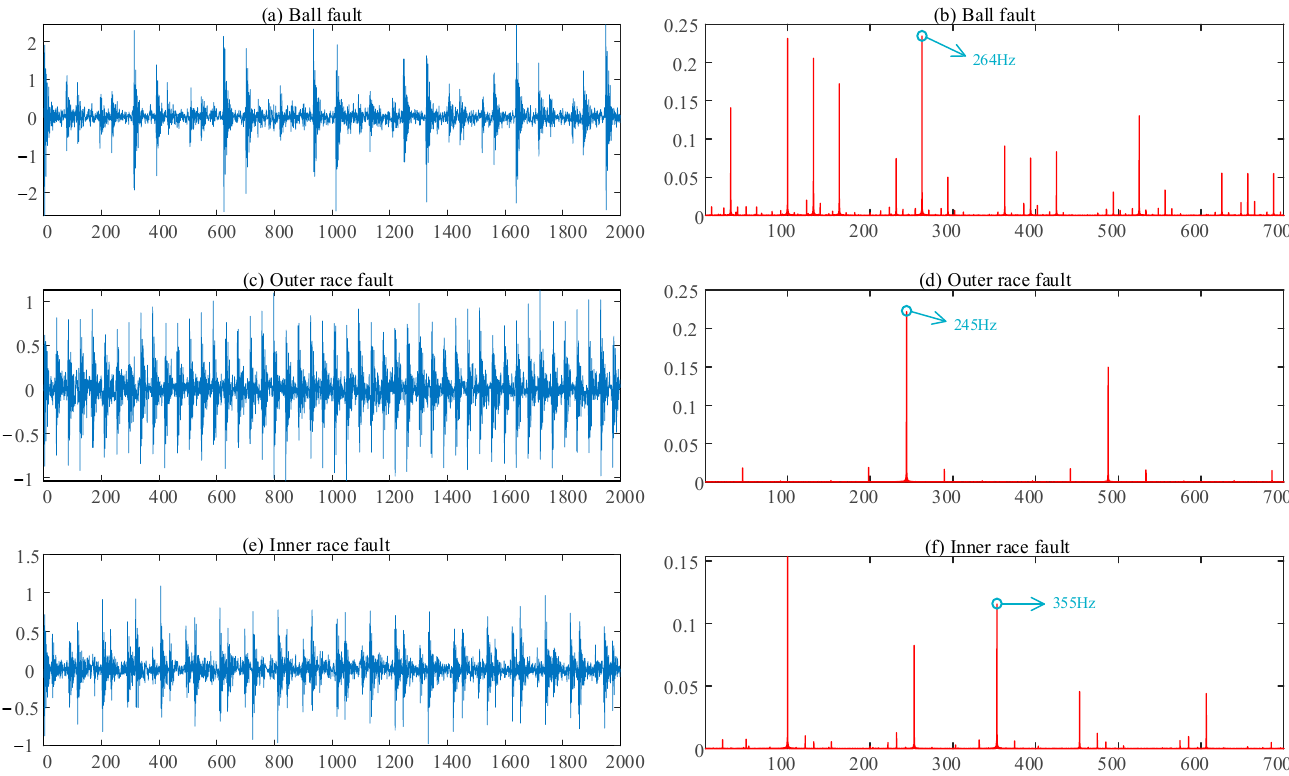
Figure 4. Time domains and spectra of simulated bearing faults: ( a ) time domain of ball fault; ( b ) envelope spectrum of ball fault; ( c ) time domain of outer race fault; ( d ) envelope spectrum of outer race fault; ( e ) time domain of inner race fault; ( f ) envelope spectrum of inner race fault.